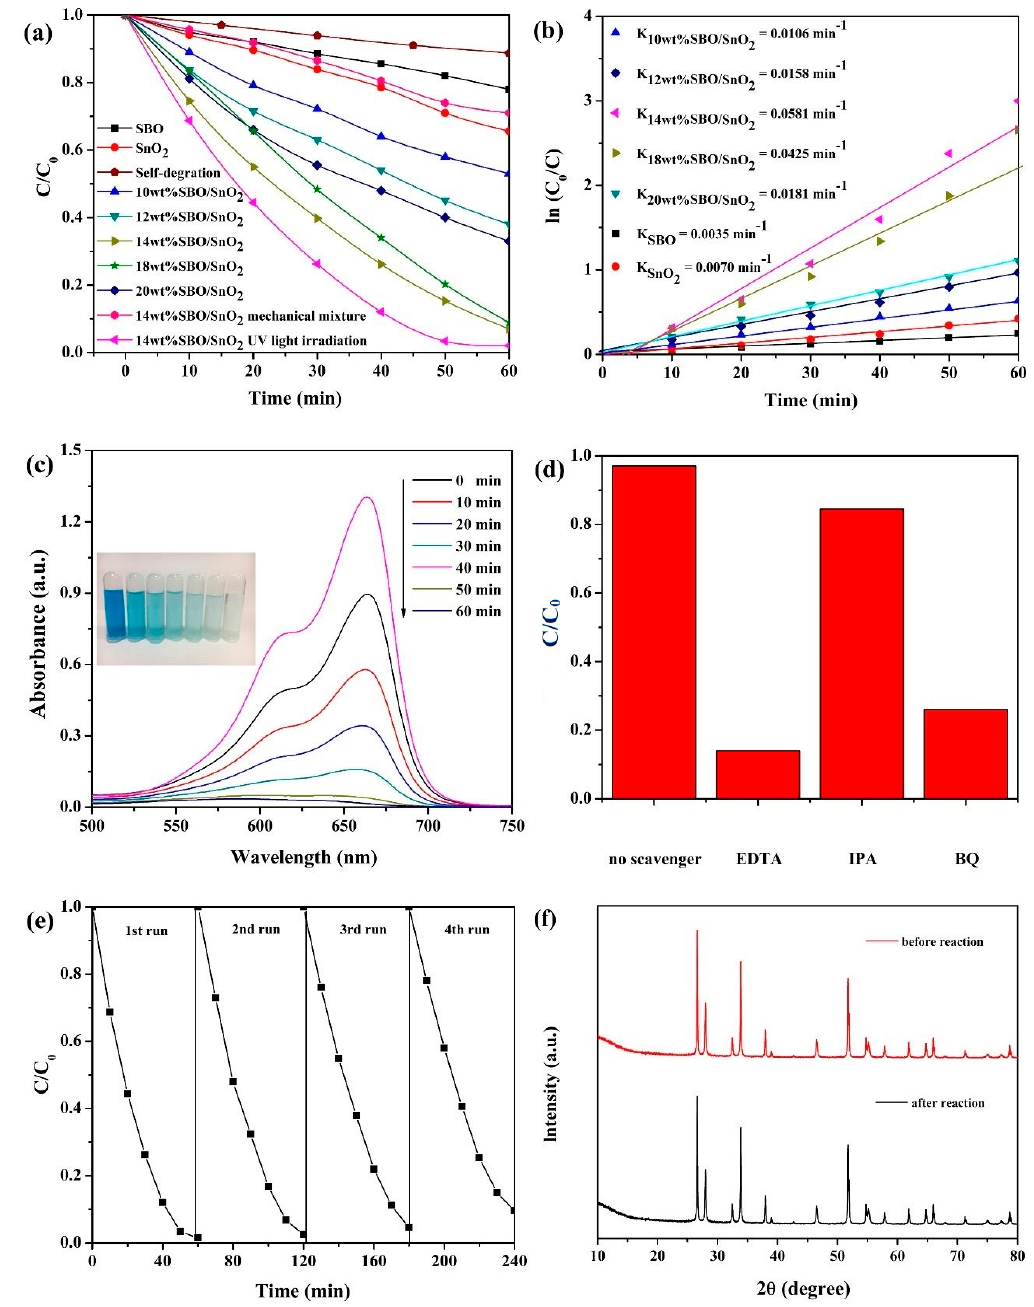
Figure 6. ( a ) Photodegradation of MB solution without photocatalyst and over the as-prepared SBO, SnO 2 , and SBO / SnO 2 with di ff erent concentration of SBO; ( b ) kinetic plot of the photodegradation of MB solution versus irradiation time; ( c ) temporal absorption spectra of MB solution in the presence of 14 wt% SBO / SnO 2 ; ( d ) degradation of MB over 14 wt% SBO / SnO 2 in the presence of di ff erent scavengers; ( e ) cycling runs of 14 wt% SBO / SnO 2 for MB degradation; and ( f ) XRD patterns of 14 wt% SBO / SnO 2 before and after a four-cycle reaction.